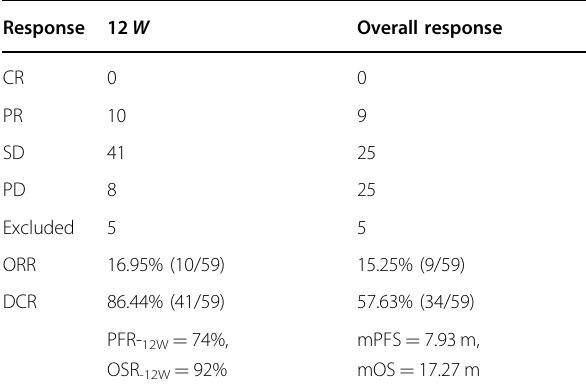
Table 2 Clinical response to apatinib in patients